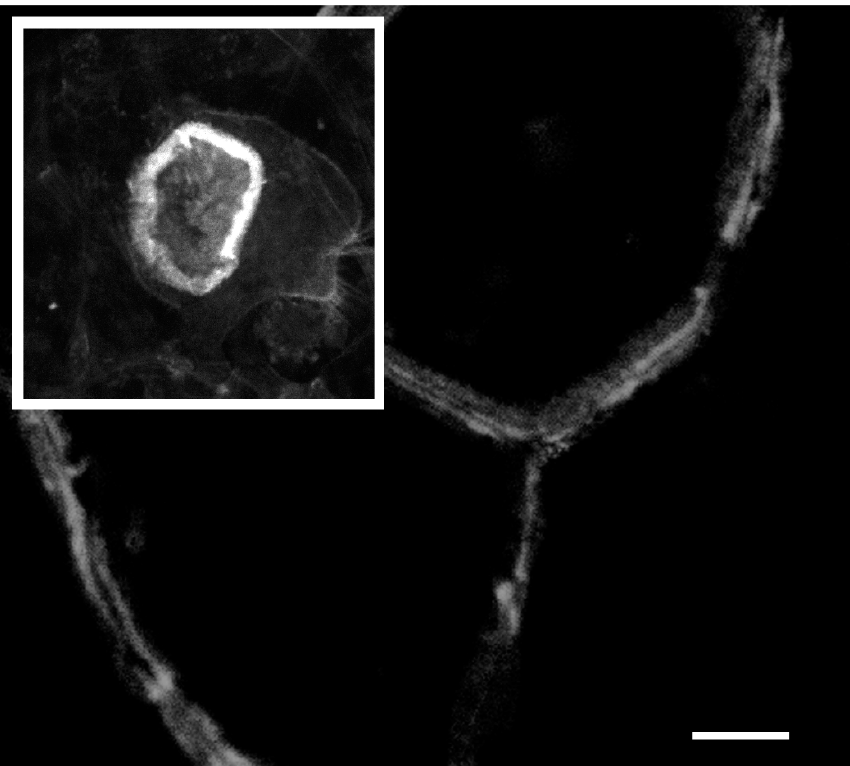
Figure 3. The actin ring of osteoclast resorbing bone (inset) is thicker, larger, and more dynamic than the actin belt of non ‐ resorbing osteoclasts on a glass coverslip. In the main picture, several large osteoclasts form an almost epithelial like sheet with the actin belt of the contacting cells forming side ‐ by ‐ side. The scale bar is 10 μ m for the inset picture and 25 μ m for the main picture.